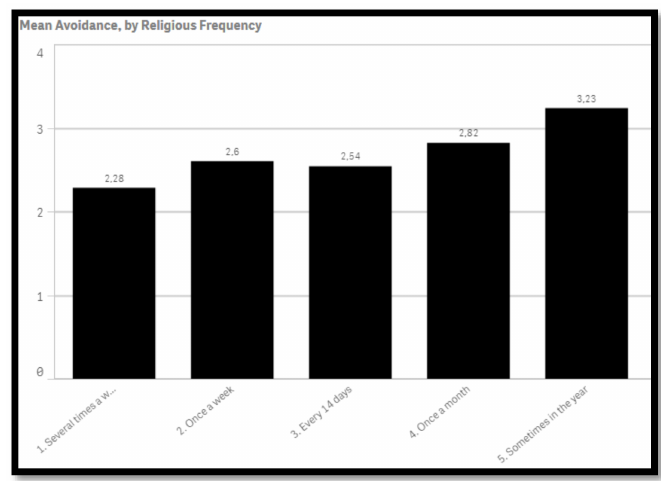
Figure 9. Avoidance, by Religious Frequency. Source: data study